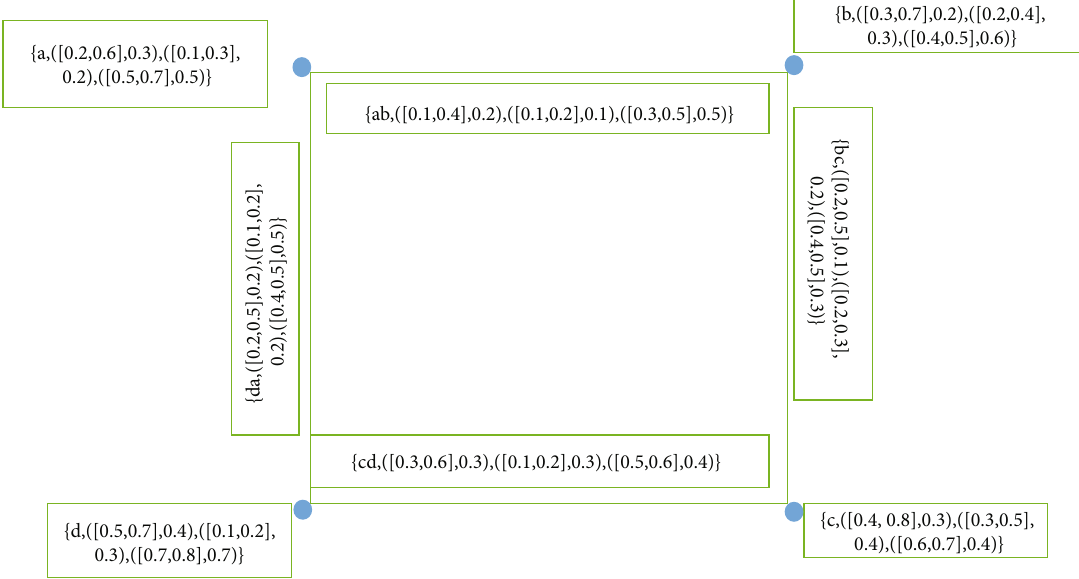
Figure 7: Represents neighborly irregular neutrosophic cubic graph.